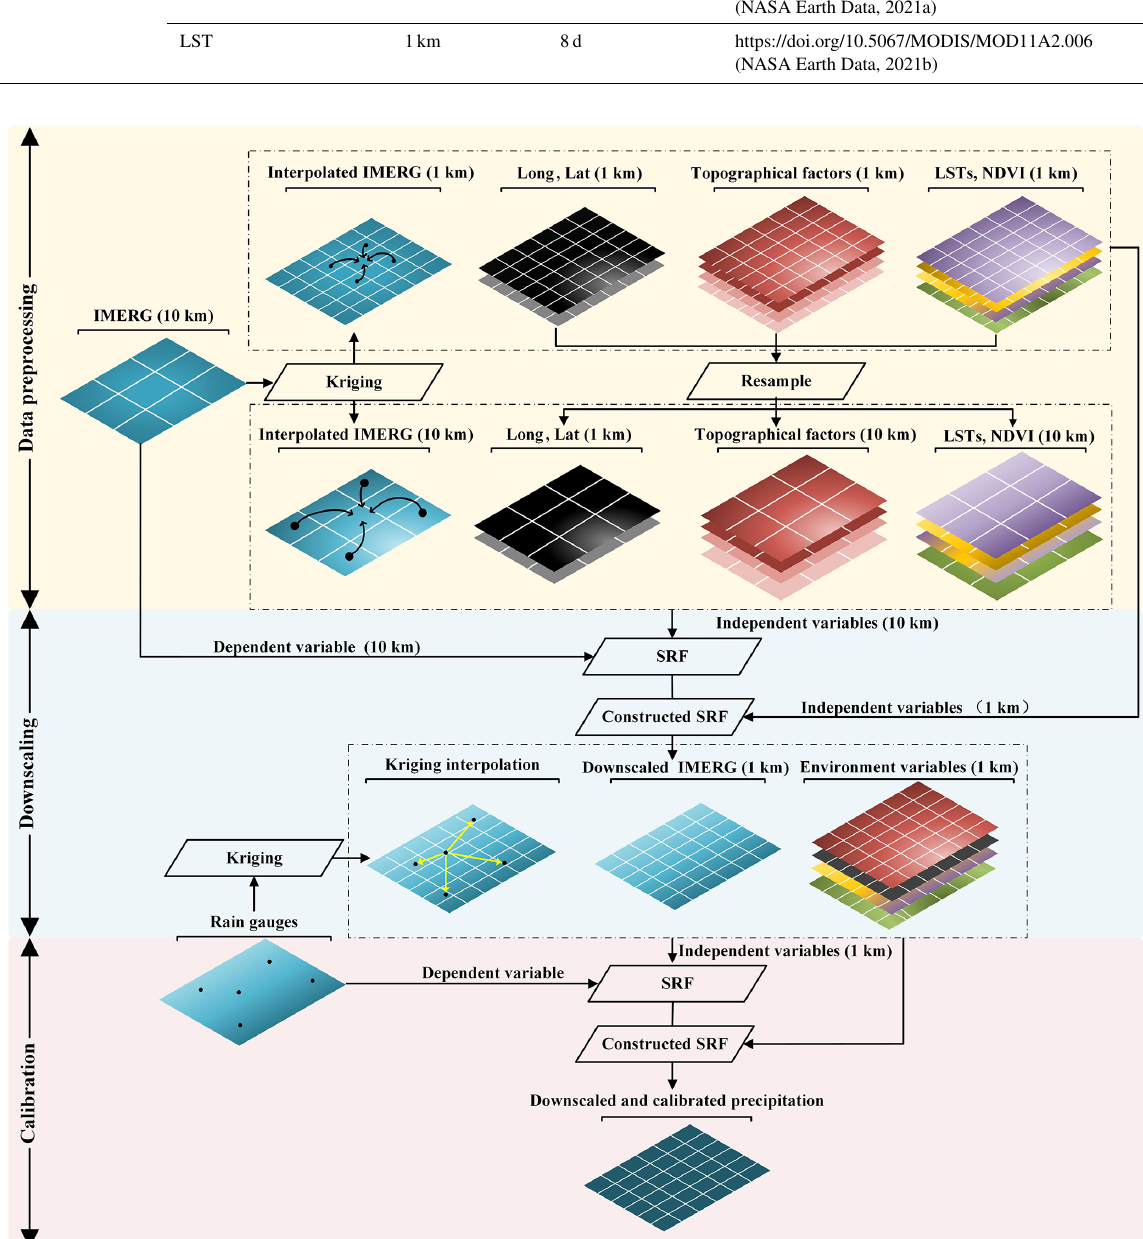
Figure 3. Flowchart of SRF-DC in this